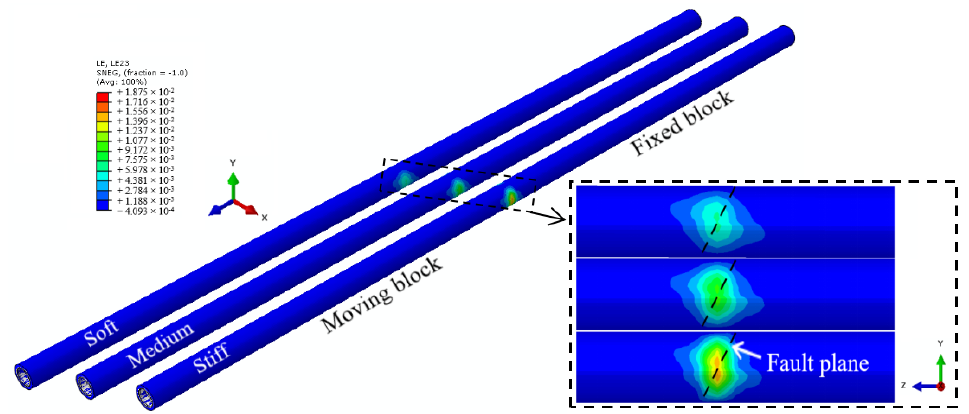
Figure 12. Circumferential shear strain nephogram of composite lining structures with different fault properties in the fault fracture zone ( △ f = 8 cm and β = 60°).